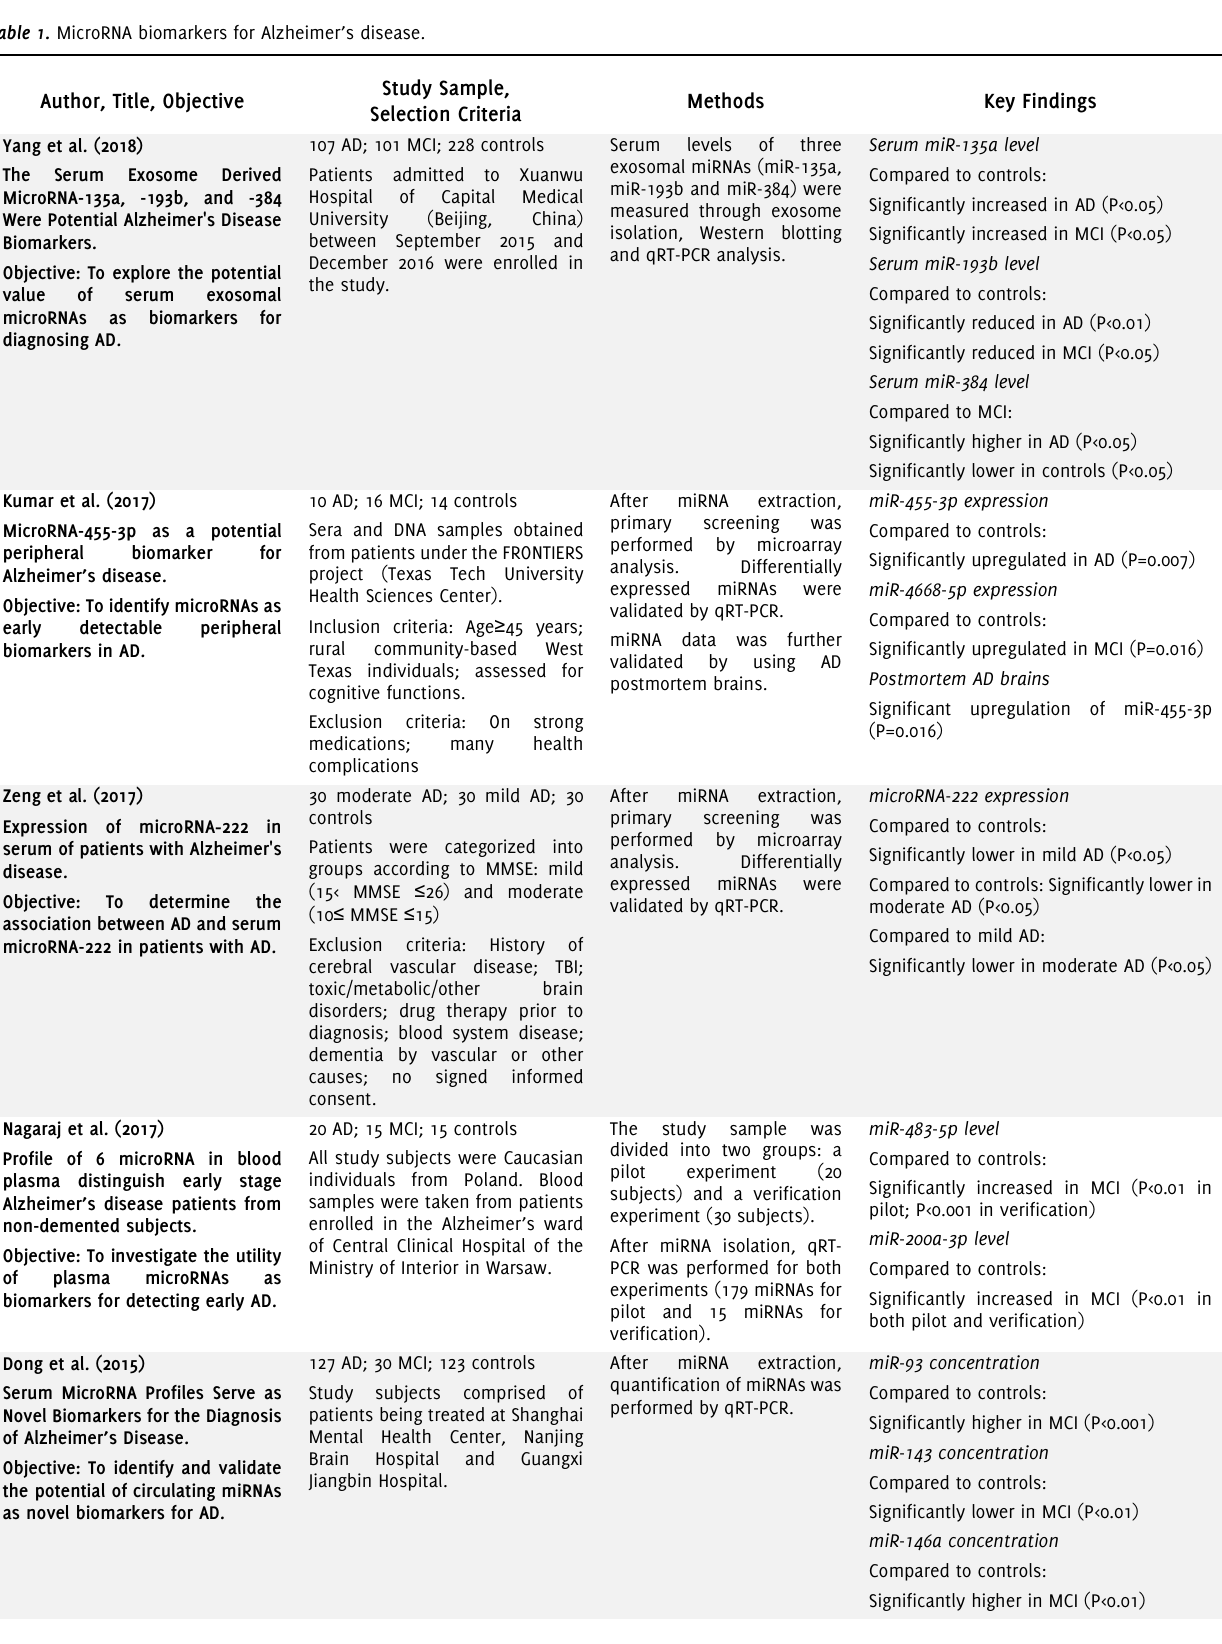
Table 1. MicroRNA biomarkers for Alzheimer’s